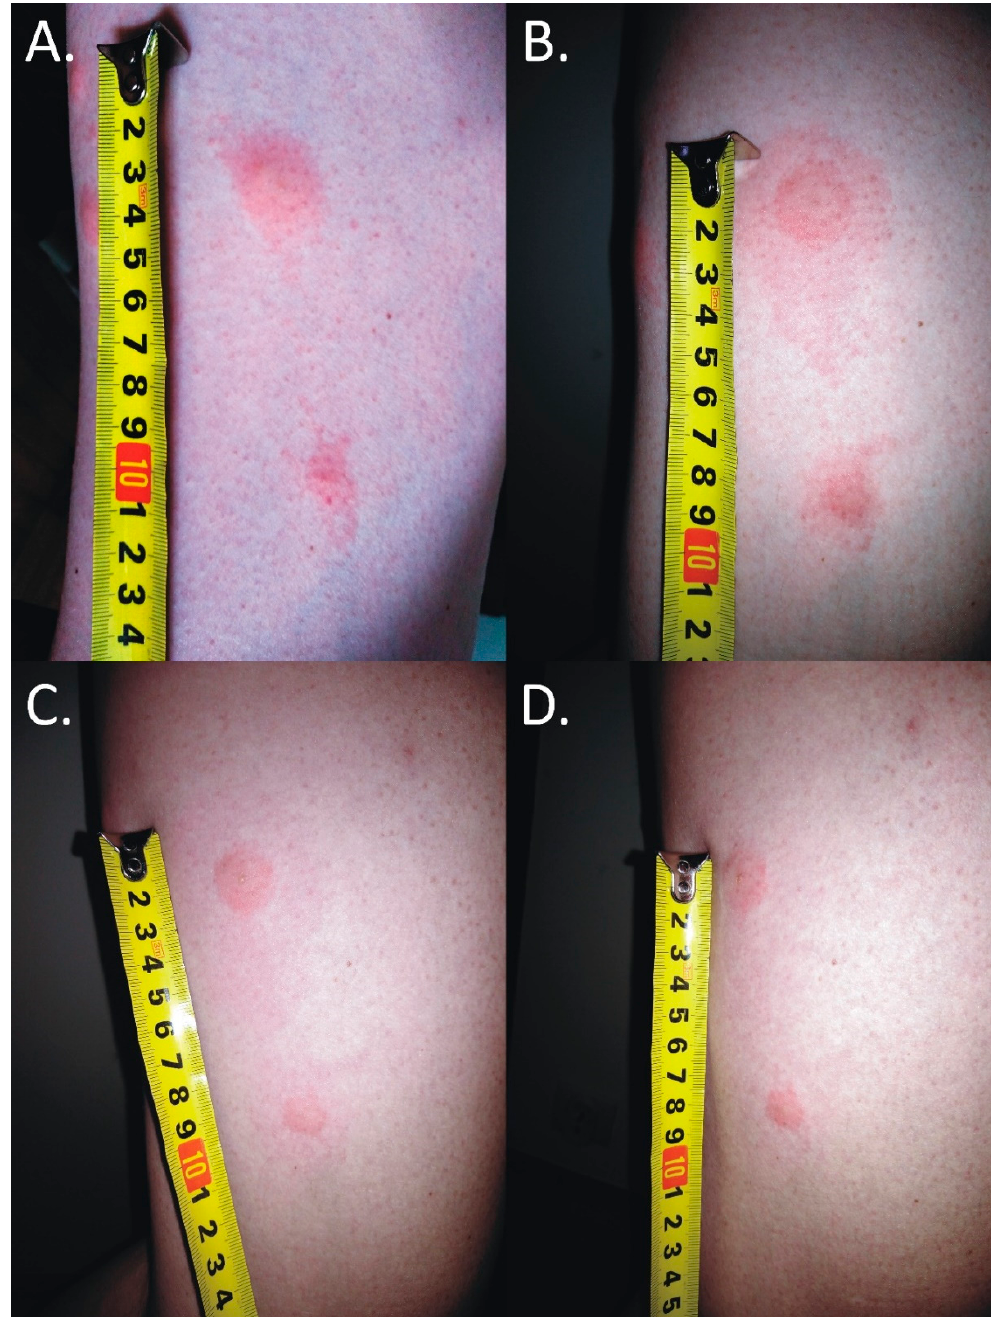
Figure 2. Inflammatory reaction to the deer ked ( Lipoptena cervi ) bite. ( A ) 25 mm × 15 mm erythema 17 h after the bite; ( B ) 50 mm × 25 mm erythema 25 h after the bite; ( C ) 68 mm × 30 mm erythema 40 h after the bite; ( D ) self-limited 50 mm × 30 mm inflammatory reaction 64 h after the bite; the black lines mark the extent of inflammatory changes.